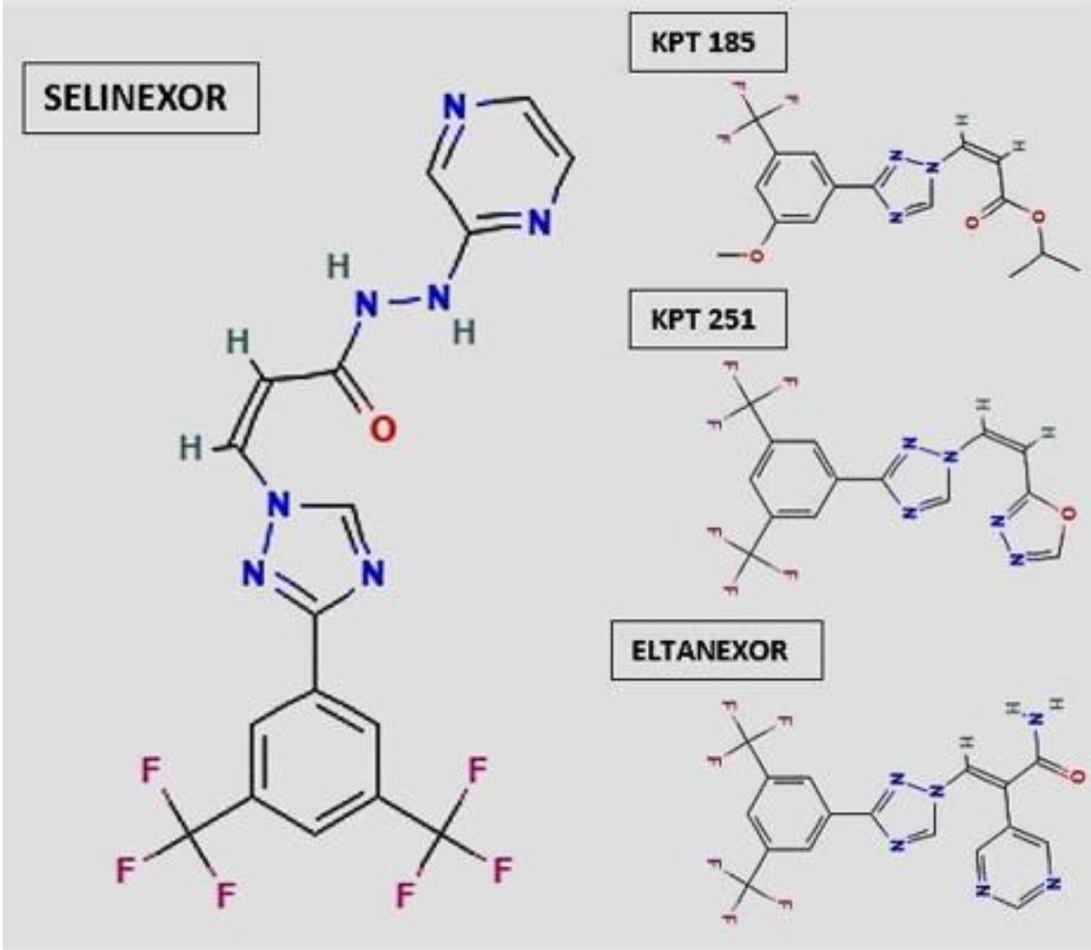
Figure 2. Selinexor, KPT185, KPT251, and Eltanexor chemical structures; in particular, Selinexor covalently binds to a cysteine residue in the nuclear export signal groove of human XPO1